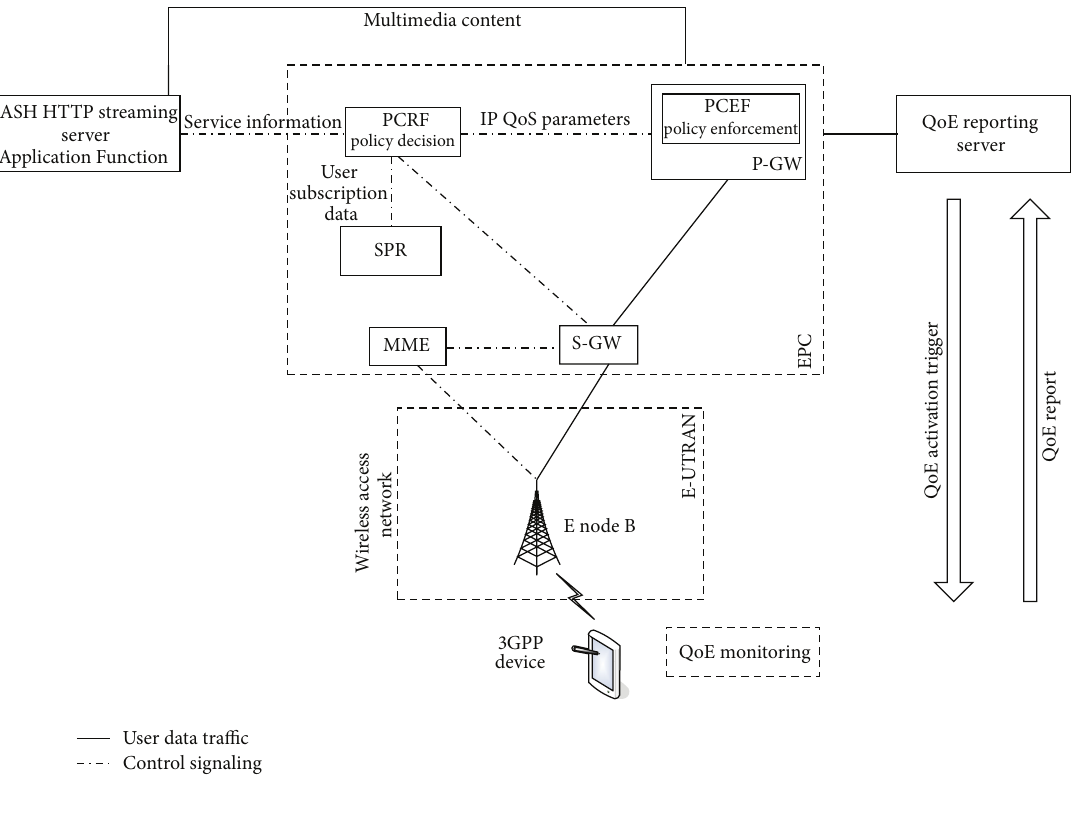
Figure 3: Example of possible PCC architecture performing end-to-end QoS/QoE delivery for DASH services (see Abbreviations).